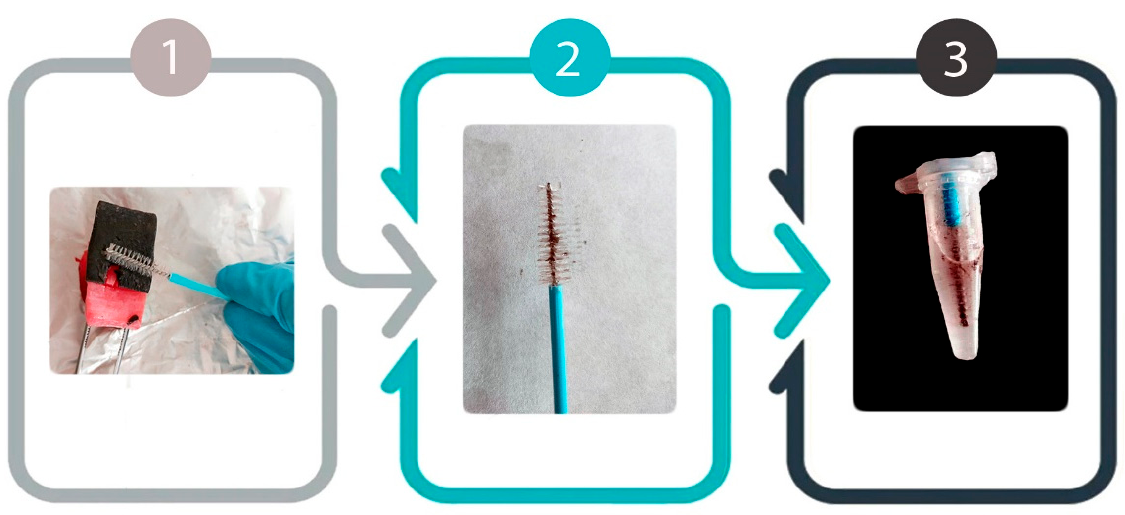
Figure 1. Workflow illustration of the cytology cell sampler skin sampling methodology. After accomplishing the procedure previously explained, the rest of both necropsies were performed by sampling and collecting representative tissues of all the major organs and lesions for subsequent analyses in order to proximate the most plausible cause